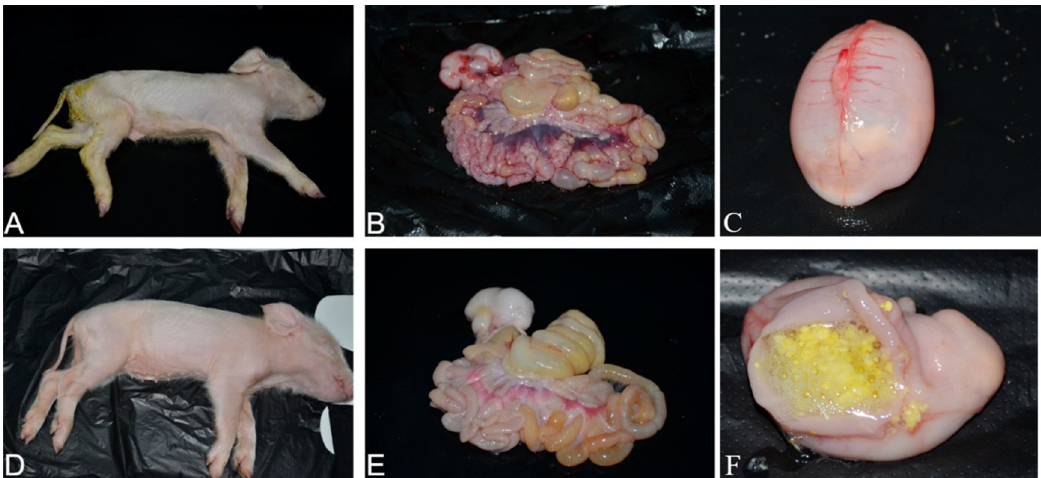
Figure 9. Pathology of PDCoV strain CHN-SC2015 in five-day-old piglets. The images are representative of experimental and control piglets. Clinical observation of a piglet challenged with PDCoV CHN-SC2015 passage 12 ( A ) or DMEM ( D ) at 5 dpi. Macroscopic lesions of gastrointestinal tissue from the infected piglet ( B ) and uninfected ( E ) at 5 dpi. Macroscopic lesions of the stomach from the infected piglet ( C and F ) at 5 dpi.